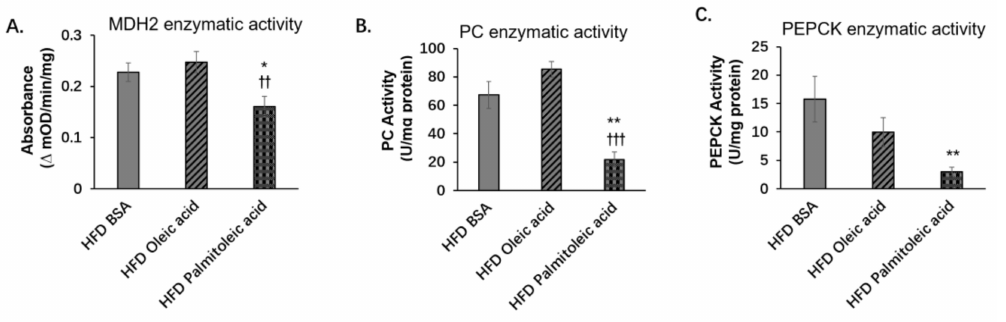
Figure 4. Palmitoleic acid reduces enzymatic activities of MDH2, PC, and PEPCK under HFD. C57BL/6N male mice of 5–6 weeks of age were fed with LFD or HFD for 12 weeks. At the 13th week, BSA, oleic acid, or palmitoleic acid was administered intragastrically. At the 18th week, mice were sacrificed, and liver tissue was collected. The enzyme activities of MDH2, PC, and PEPCK in the liver were measured. ( A ) Enzymatic activity of MDH2 in the liver of HFD-fed mice. ( B ) Enzymatic activity of PC in the liver of HFD-fed mice. ( C ) Enzymatic activity of PEPCK in the liver of HFD-fed mice. The data are mean ± s.e. (error bars). n = 4–7 mice per group. *, p < 0.05, **, p < 0.01, HFD BSA vs. HFD palmitoleic acid; ††, p < 0.01, †††, p < 0.001, HFD oleic acid vs. HFD palmitoleic